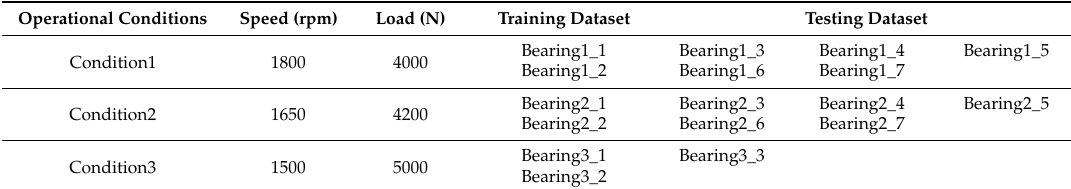
Table 1. Bearing dataset with operational conditions.